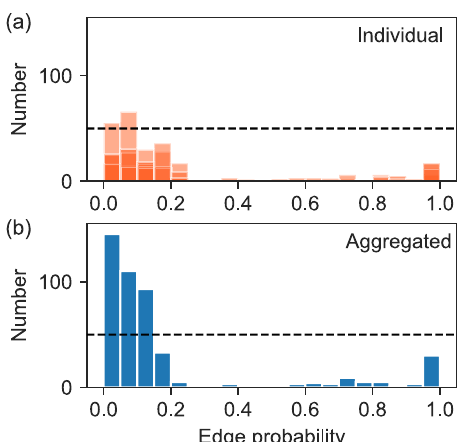
Fig. 4 Illustration of the effect of data aggregation on edge uncertainty.